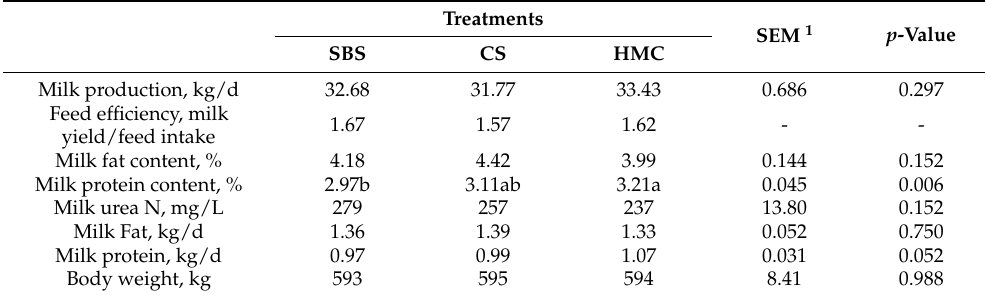
Table 4. Milk production and body weight of grazing dairy cows supplemented with PMR compos- ited by sugar beet silage, corn silage, or